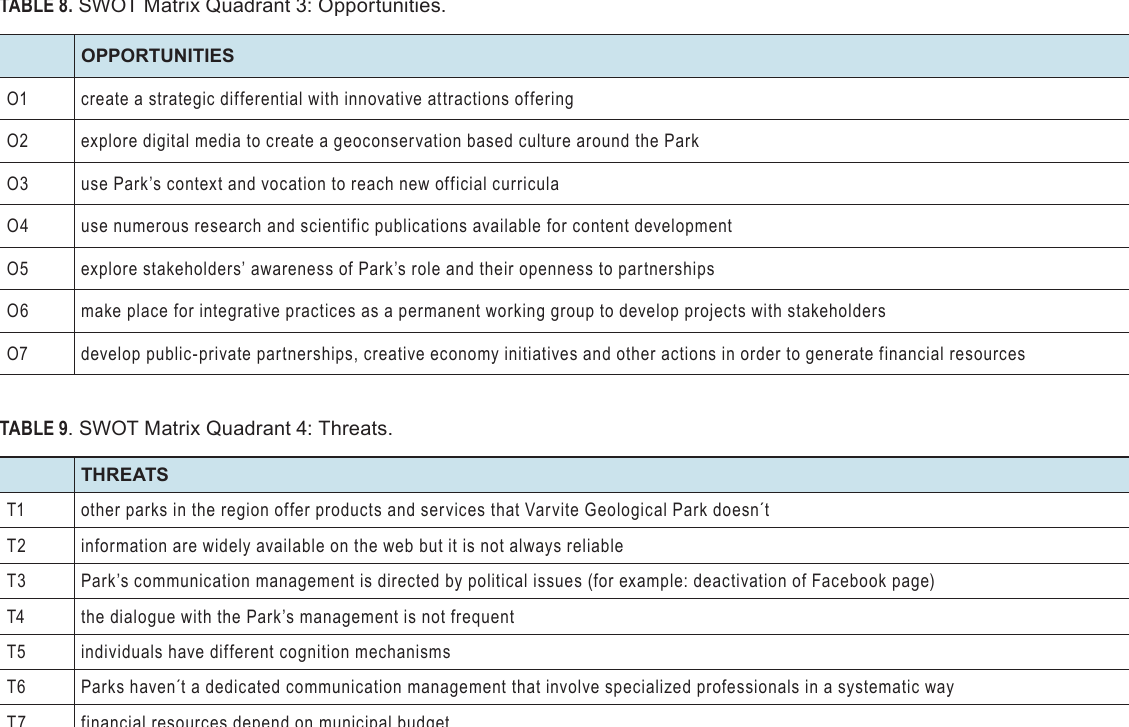
TABLE 8. SWOT Matrix Quadrant 3: Opportunities.